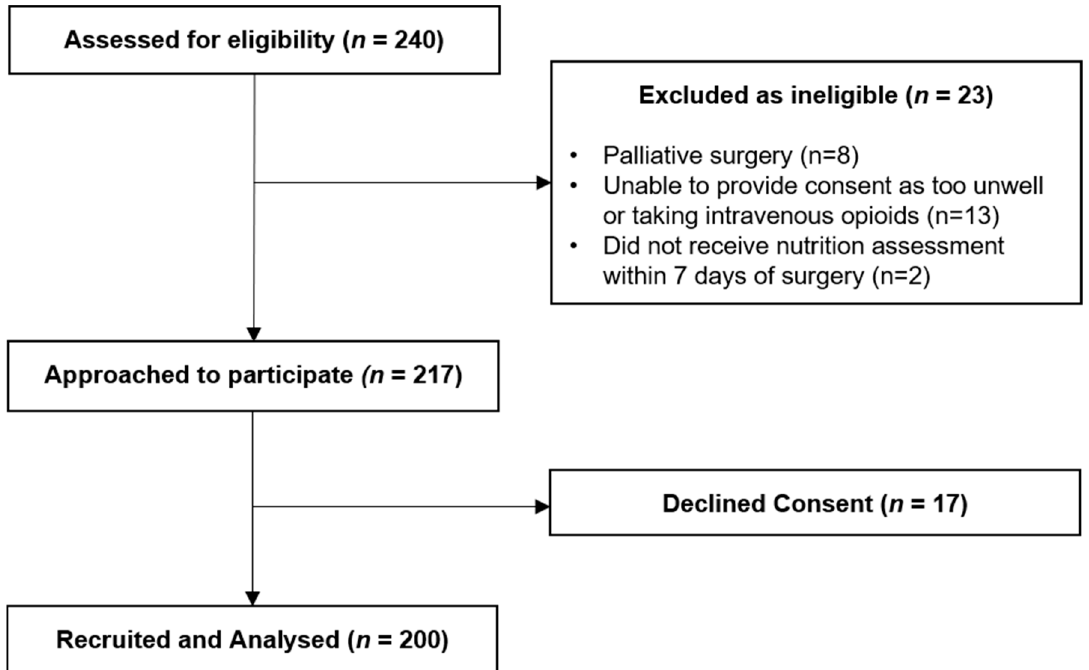
Figure 1. Participant flow diagram.